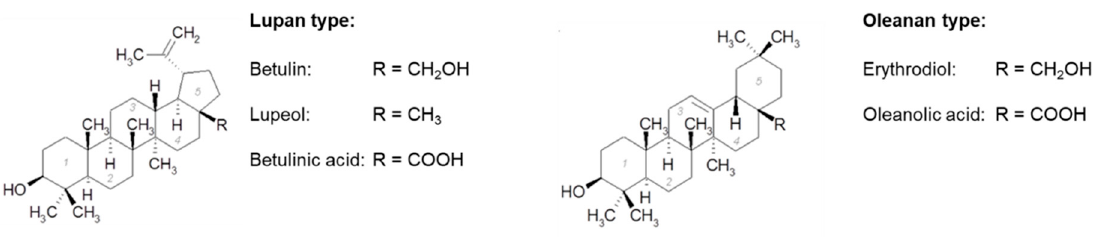
Figure 1. Chemical structure of triterpenoids with Lupan and Oleanan type skeleton .